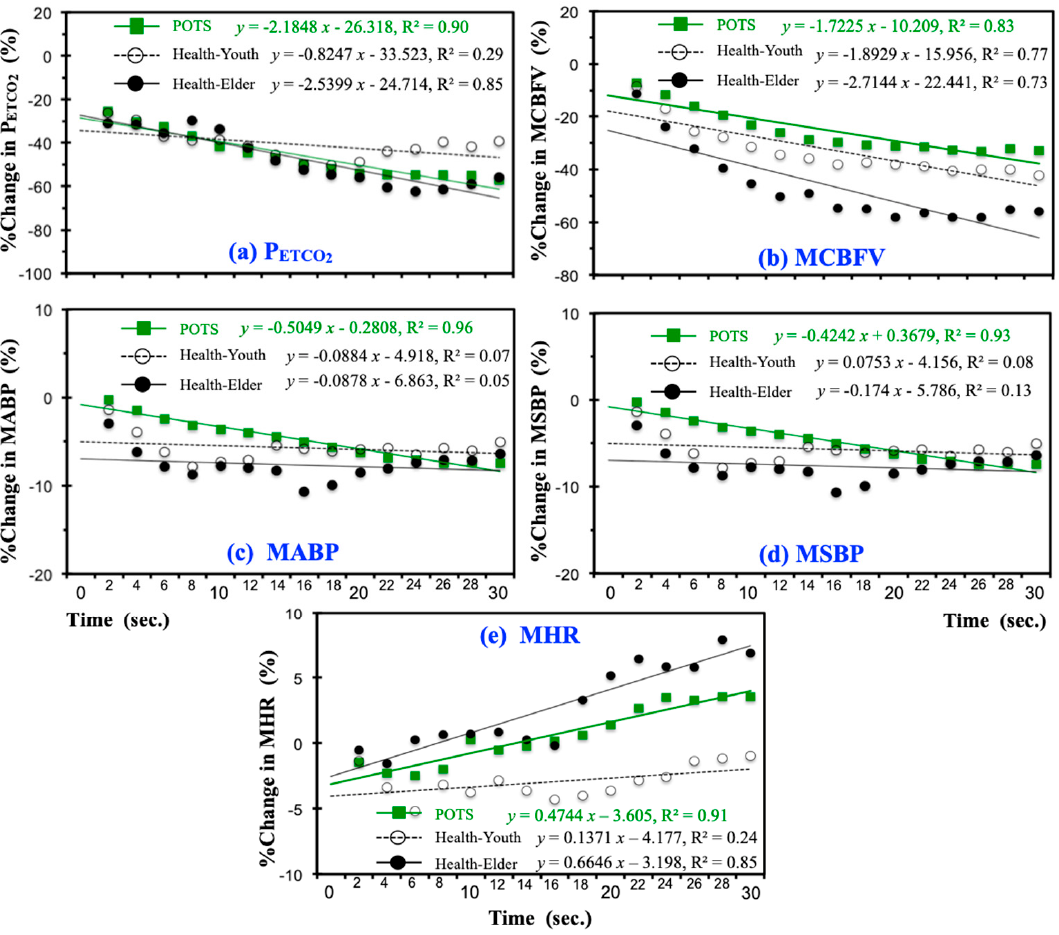
Figure 4. Mean percentage changes in ( a ) P ETCO 2 , ( b ) MCBFV, ( c ) MABP, ( d ) MSBP, and ( e ) MHR during the initial 30 s (15 breathing cycles) of hyperventilation for the three groups with linear regression.